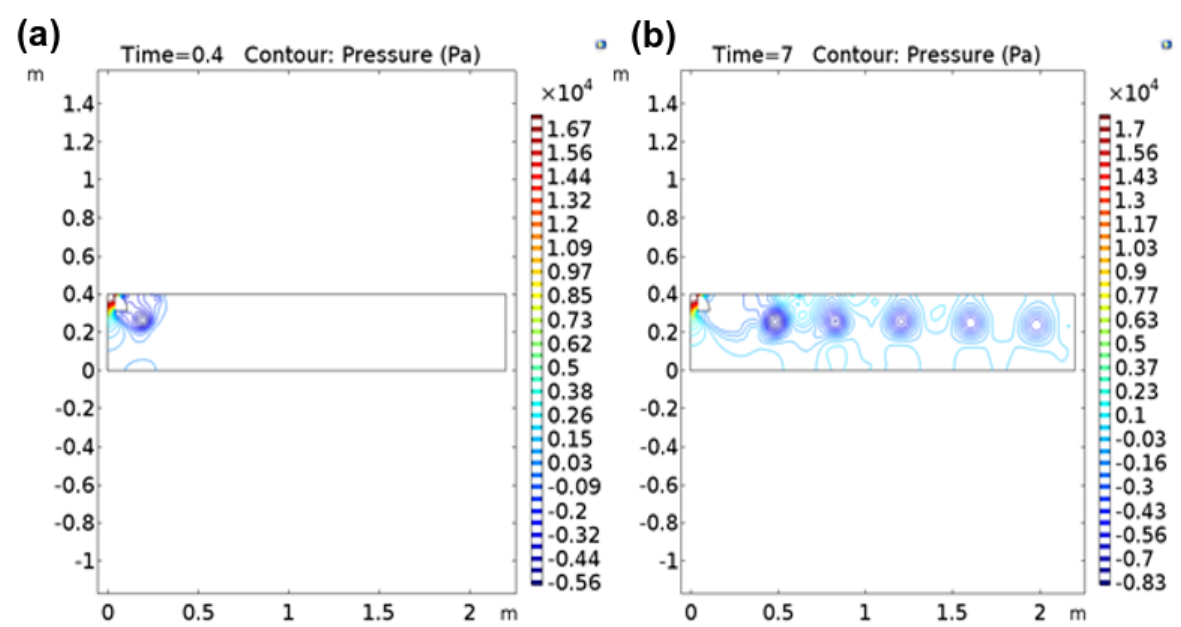
Figure 7. Scheme of the contour pressure at ( a ) lower and ( b ) higher time range.